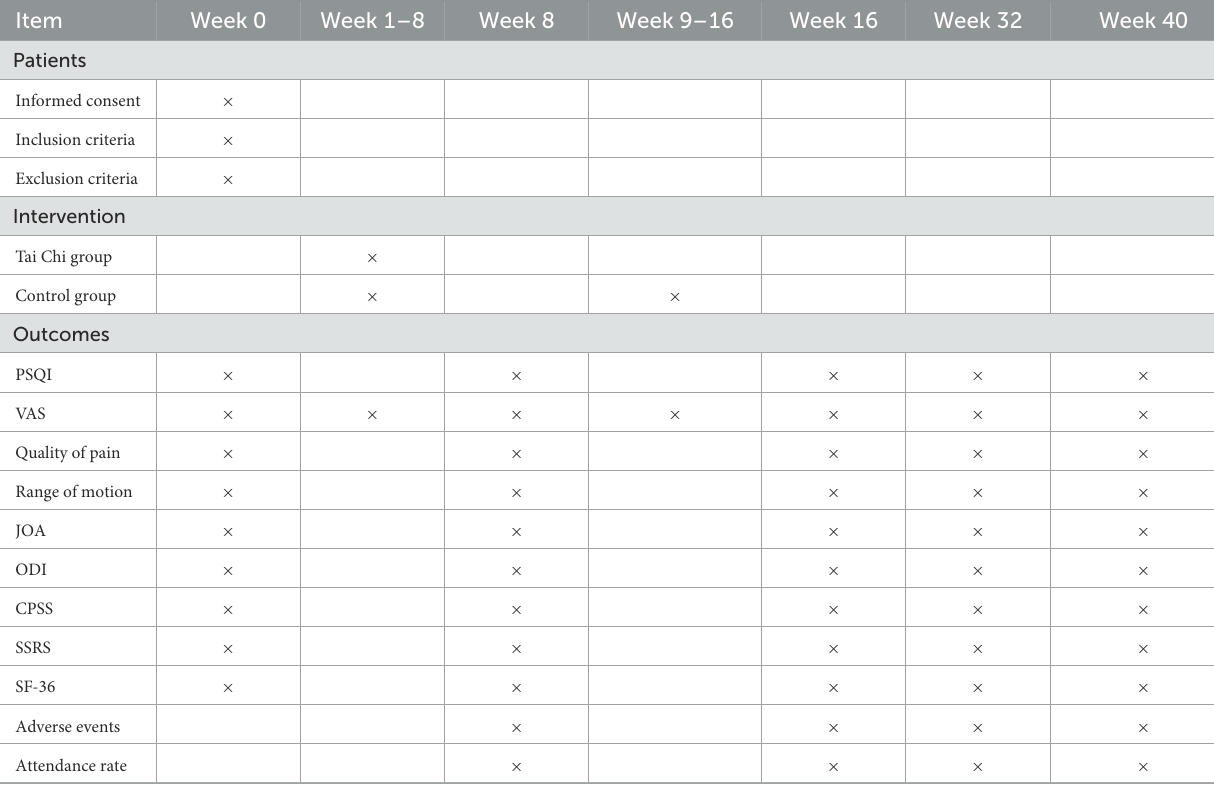
TABLE 1 Schedule of patients, intervention,